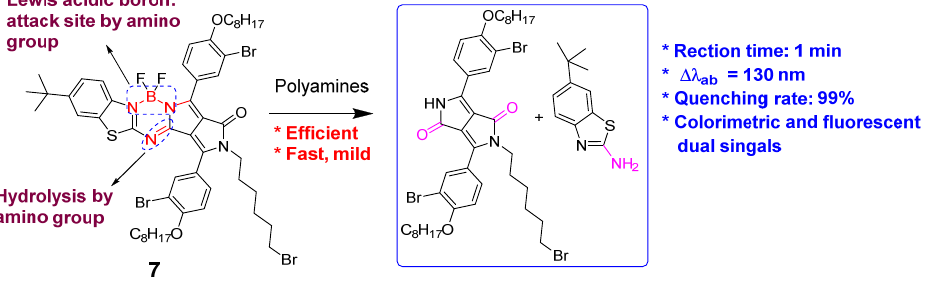
Figure 8. The possible sensing mechanism between compound 7 and polyamines [63].